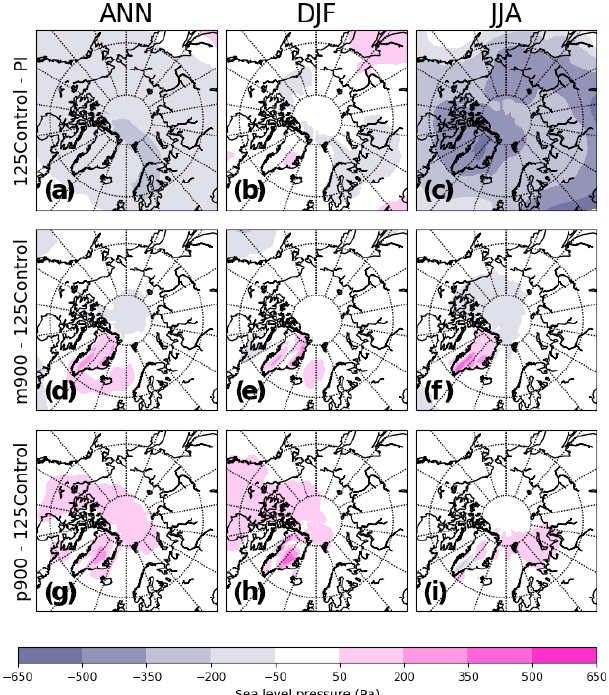
Figure 3. ANN, DJF and JJA mean sea level pressure anoma- lies (Pa) for m900 (d–f) and p900 (g–i) compared to the 125Con- trol simulation. Also shown are sea level pressure anomalies for 125Control compared to the PI simulation (a–c) . Only the anoma- lies statistically significant at the 95% confidence level are dis- played.